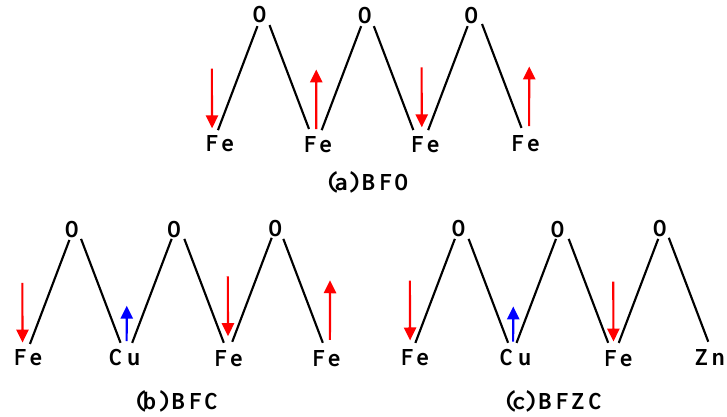
Figure 5. Scheme of the spins arrangement on pure ( a ) BFO, ( b ) BFC, and ( c ) BFZC.